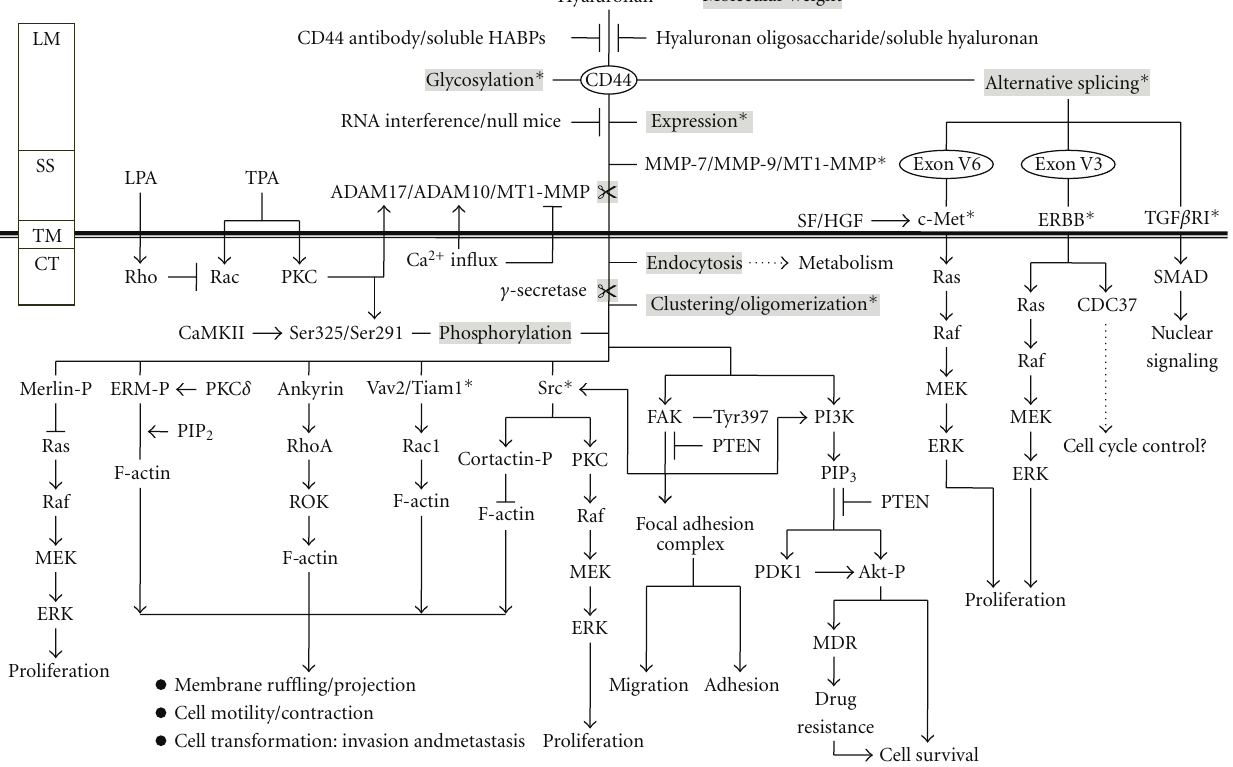
Figure 1: Signaling through CD44: hyaluronan binding to a receptor such as CD44 or RHAMM will cause a conformational change in the receptor. In the case of CD44, γ -secretase cleavage of the intracellular fragment can lead to phosphorylation of cellular components such as CaMK (calmodulin kinase). Clustering of the intracellular portion of CD44 with cellular proteins such as merlin, Src, and PKC leads to downstream activation of the Raf/MEK/ERK pathway, enhancing cell proliferation. Alternatively, activation with ankyrin, ERM, or Vav2/Tiam1 leads to F-actin activation and cytoskeletal rearrangement, membrane ru ffl ing, and cell motility. Hyaluronan signaling also regulates cell migration and adhesion through interaction of PI3K and activation of the focal adhesion complex. PI3K activation by hyaluronan signaling, when incorporated with the Akt pathway, may also lead to MDR and cell